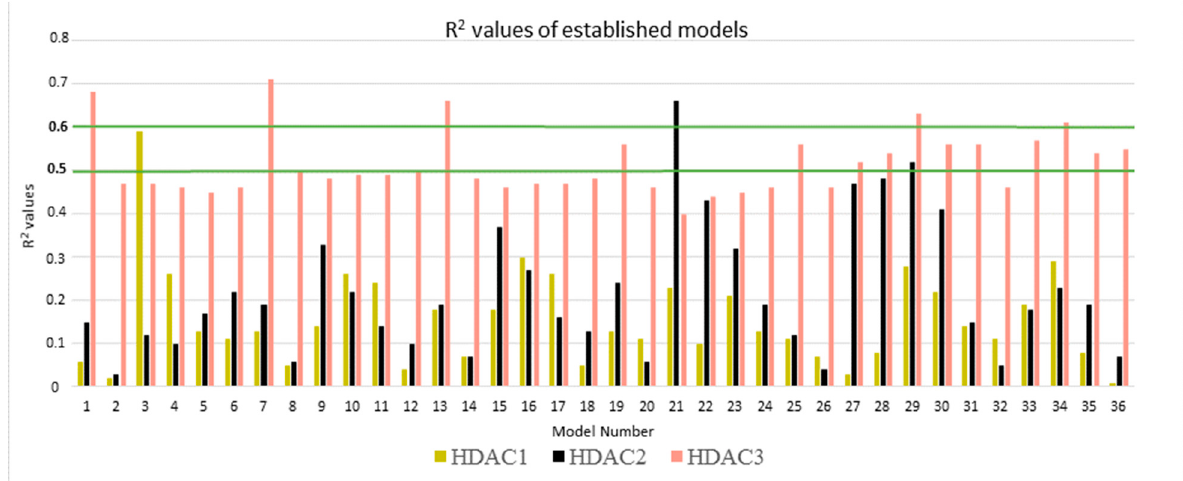
Figure 5. The R 2 values of established predictive models for HDAC1 (dark yellow bars), HDAC2 (black bars) and HDAC3 (salmon bars). Green lines represent the thresholds for model selection.